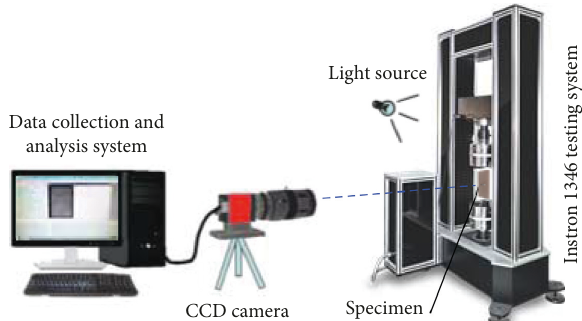
Figure 2: Schematic diagram of experimental